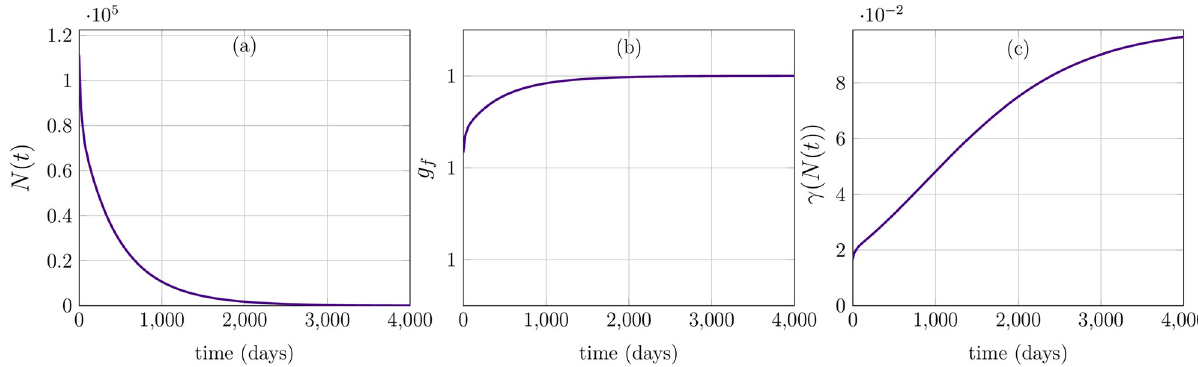
Fig 5. Trivial steady-state solution. (a) Total population of cells N ( t ) decays to zero. (b) Growth-factors g f remain maximum due to decline in cell count. (c) Gamma function γ increasing to its maximum value due to less number of